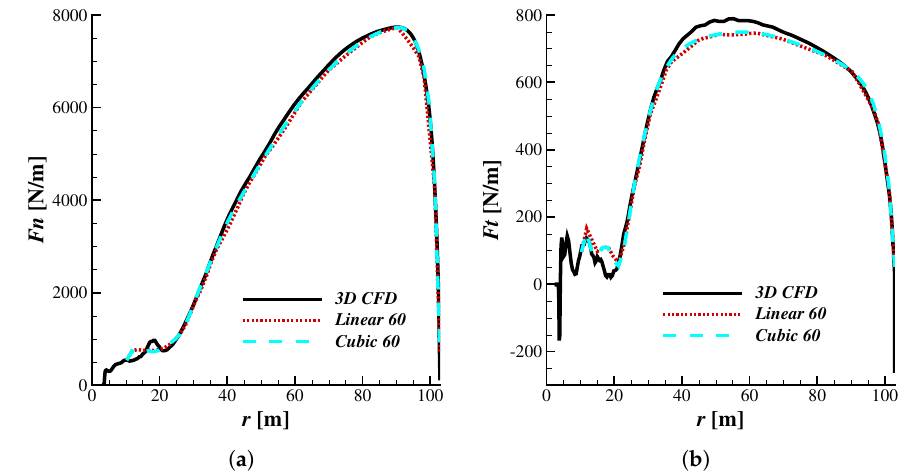
Figure 16. Effects of the radial interpolation order on the sectional force distributions along the blade radius; ( a ) normal force, ( b ) tangential